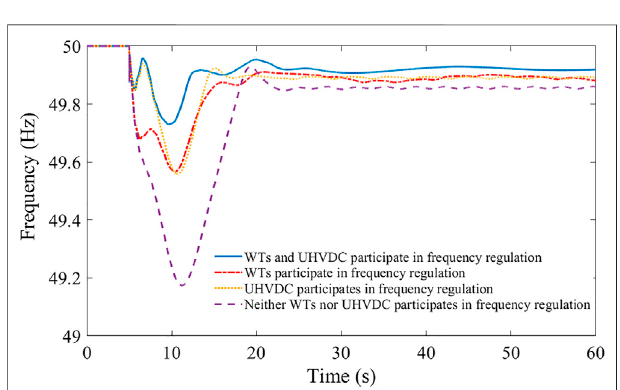
FIGURE 8 | Frequency curves under different frequency control